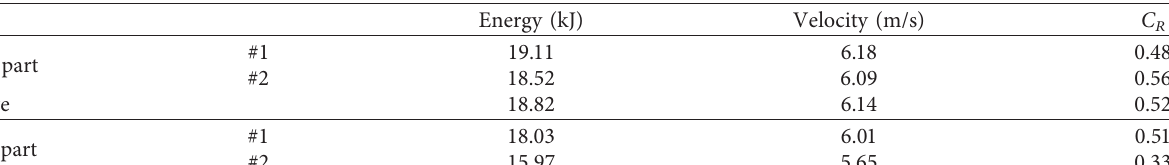
Figure 2: Pendulum test for the restitution coefficient: (a) initial position; (b) final position. Table 2: Pendulum test results.